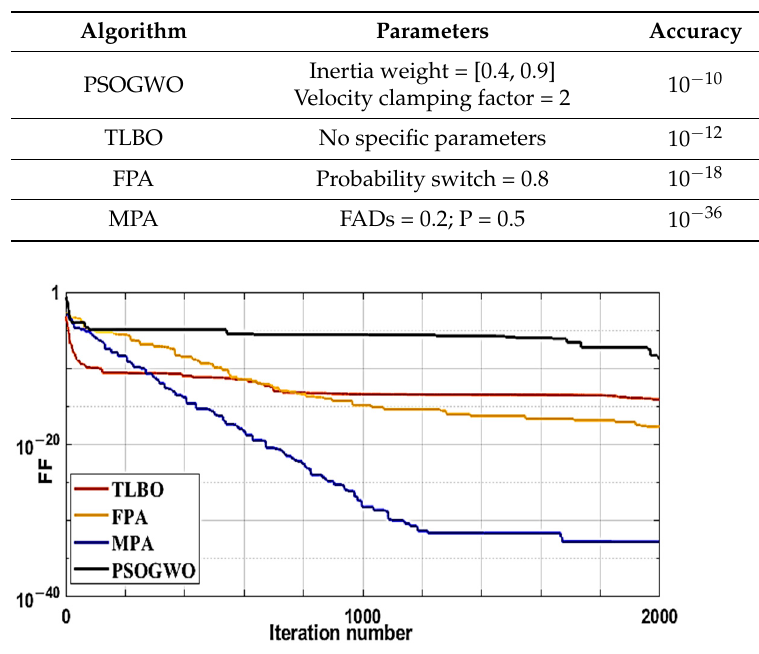
Table 2. Comparison among different algorithms for M i = 0.7, 2000 iterations, population size of 70 and 10 trial runs in an 11-level inverter.